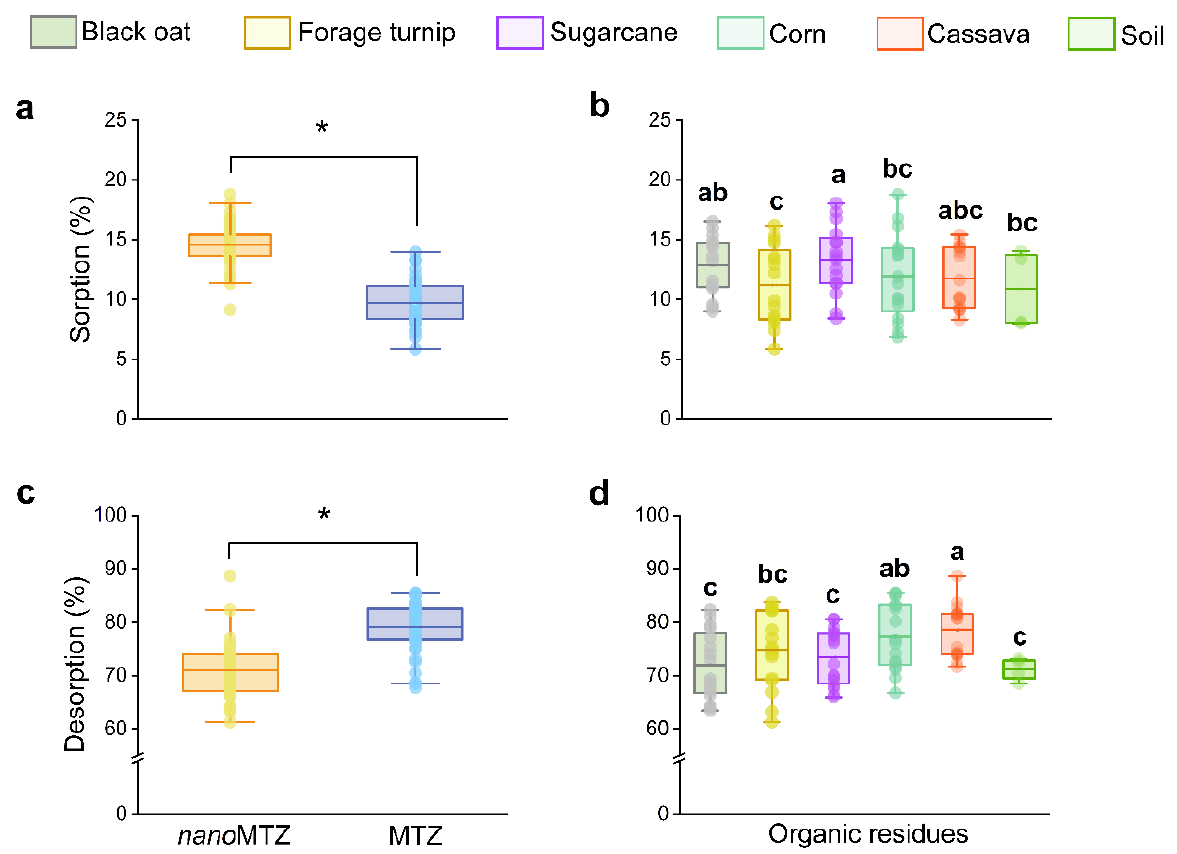
Figure 4. Sorption ( a , b ) and desorption ( c , d ) of nano MTZ and conventional MTZ in soil amended with fresh organic residues. Formulations and residues were compared separately. Asterisks indicate differences between formulations in ( a , c ) (F-test, p < 0.05), and lowercase letters indicate differences between organic residues in ( b , d ) (Tukey’s test, p < 0.05), separately. Boxes represents the 25–75% percentiles. The line inside the box indicates de mean, the bars indicates the data range and the circles outside the bars represents outliers.